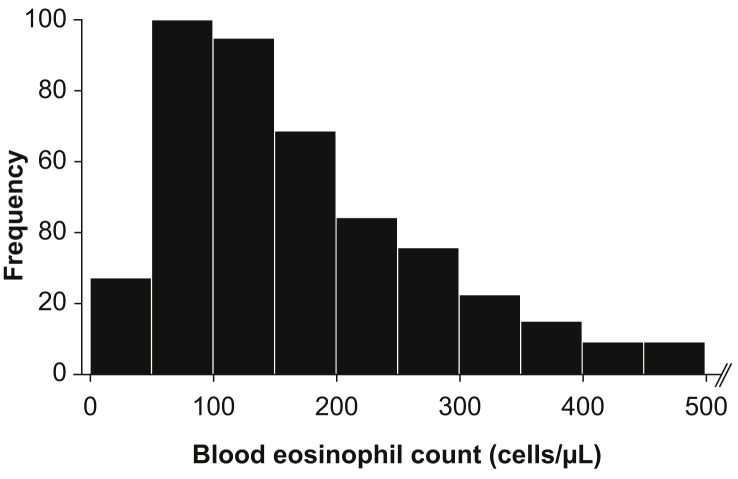
Distribution of blood eosinophil counts in non-asthmatic participants (N = 450)